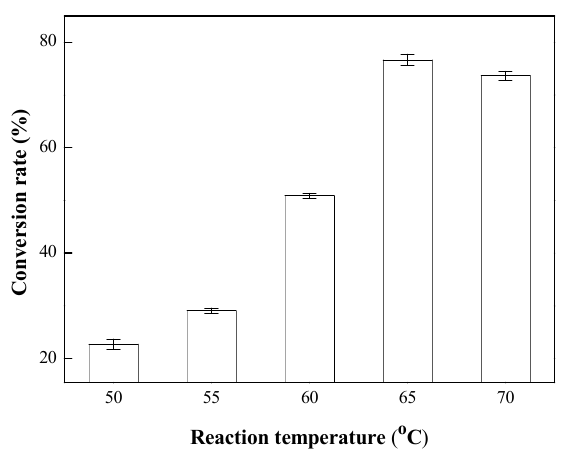
Figure 7. Effect of reaction temperature on the transesterification reaction. Reaction conditions: methanol-to-oil molar ratio: 6:1; catalyst amount: 4 wt %; rotation speed: 7000 rpm; reaction time: 60 min; reaction temperature: 50–70 °C.